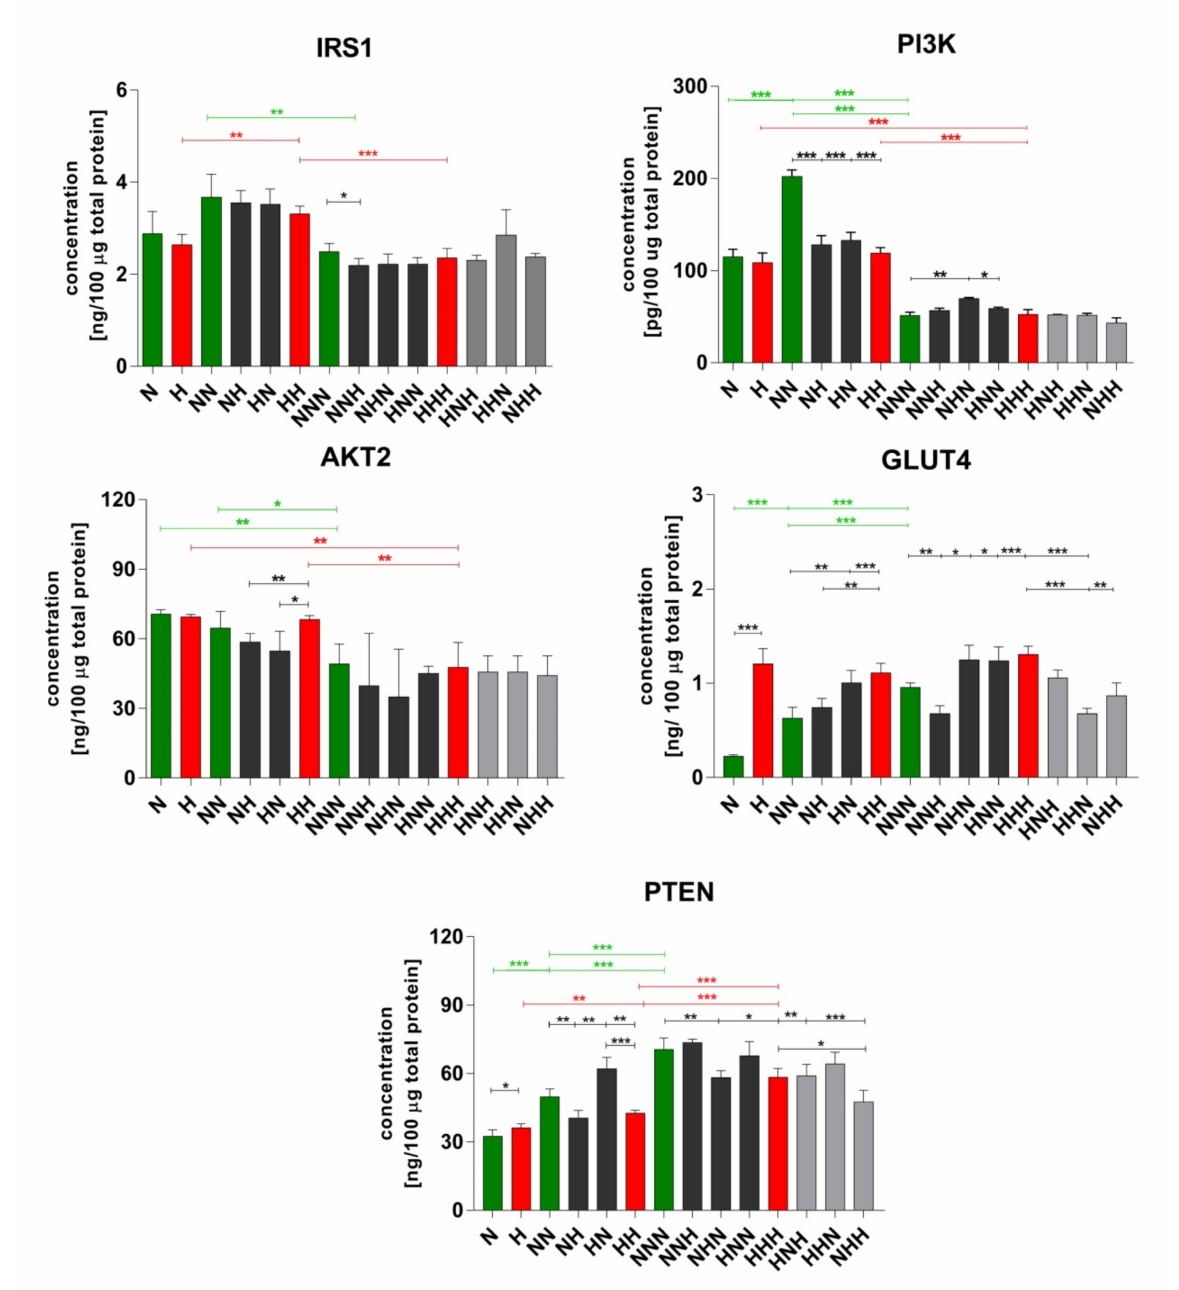
Figure 2. Protein expression profiles of IRS1, PI3K, AKT2, GLUT4, and PTEN were evaluated after completion of prolifera- tion, differentiation, and maturation of visceral cells cultured in chronic/intermittent normoglycemic (N) and hyperglycemic (H) conditions. Data are expressed as mean ± SEM in green (NG), red (chronic HG), dark grey (single HG hit), and light grey (double HG hit). Differences in expression levels between two particular culture variants were evaluated using a two-tailed t -test. One-way ANOVA with a post-hoc Tukey test was used for the calculation of statistical significance of changes observed during ADG in NG and HG. (***): p ≤ 0.001; (**): p ≤ 0.01; (*): p ≤